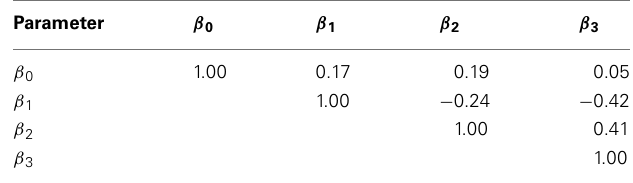
Table 4 | Sample Spearman rank correlations between hill slope parameter estimates for dose-response curves of LCLs exposed to